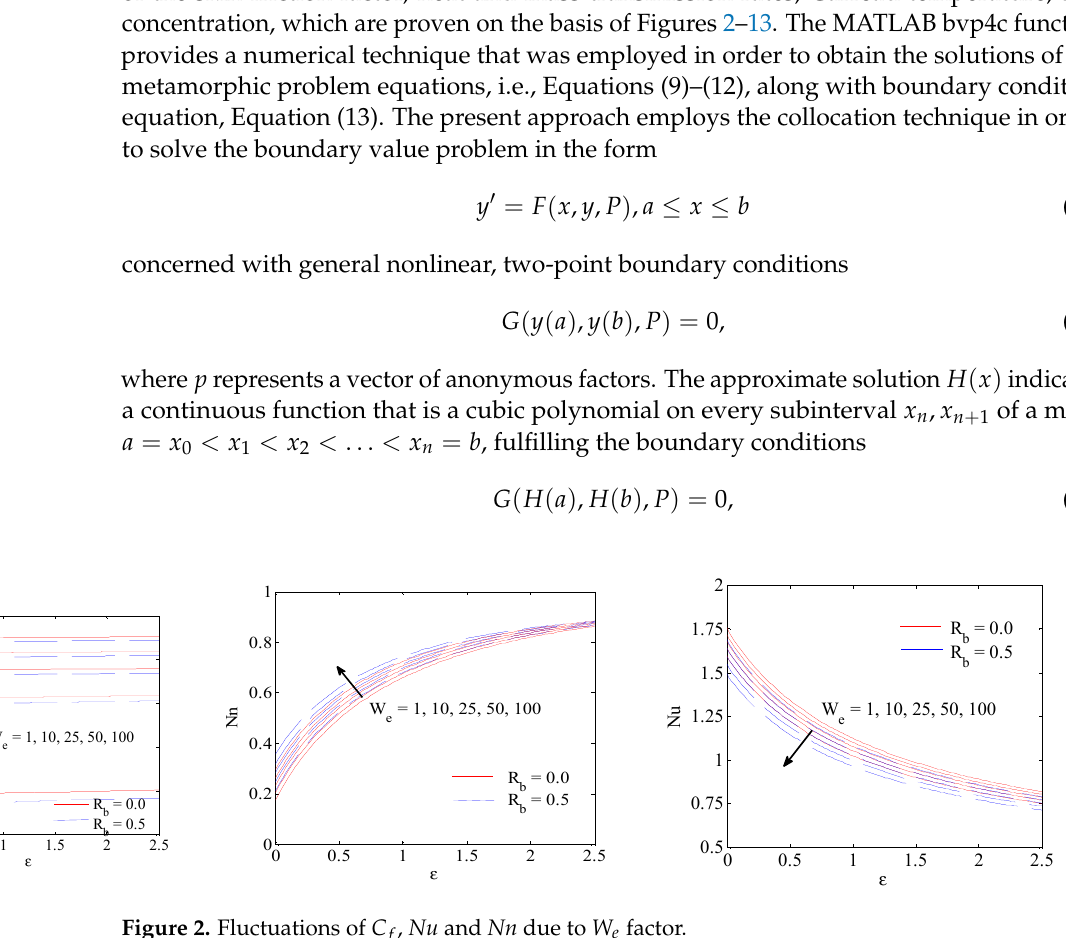
Figure 3. Fluctuations of C (cid:2916) , Nu and Nn due to R (cid:2919) factor.